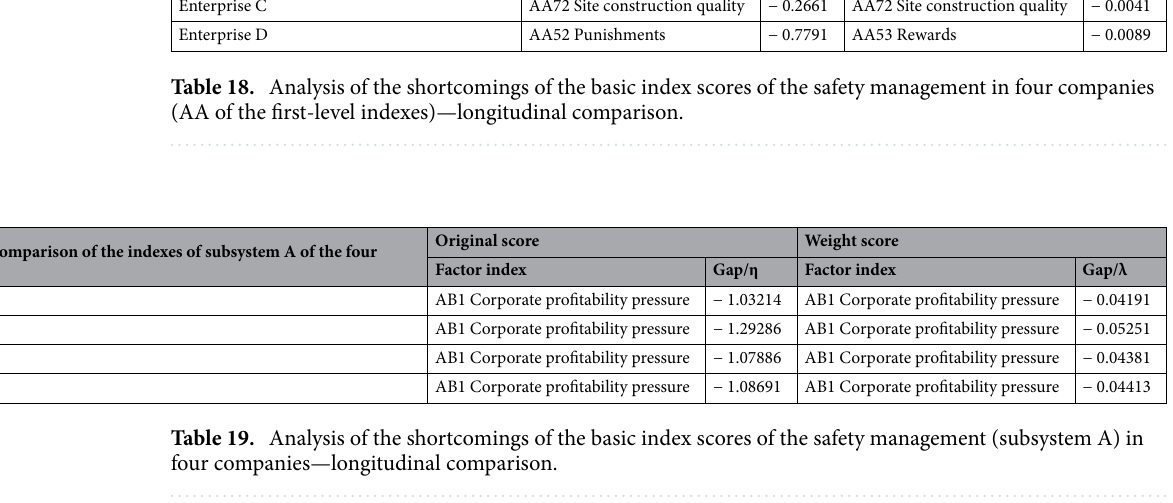
Table 19. Analysis of the shortcomings of the basic index scores of the safety management (subsystem A) in four companies—longitudinal comparison.